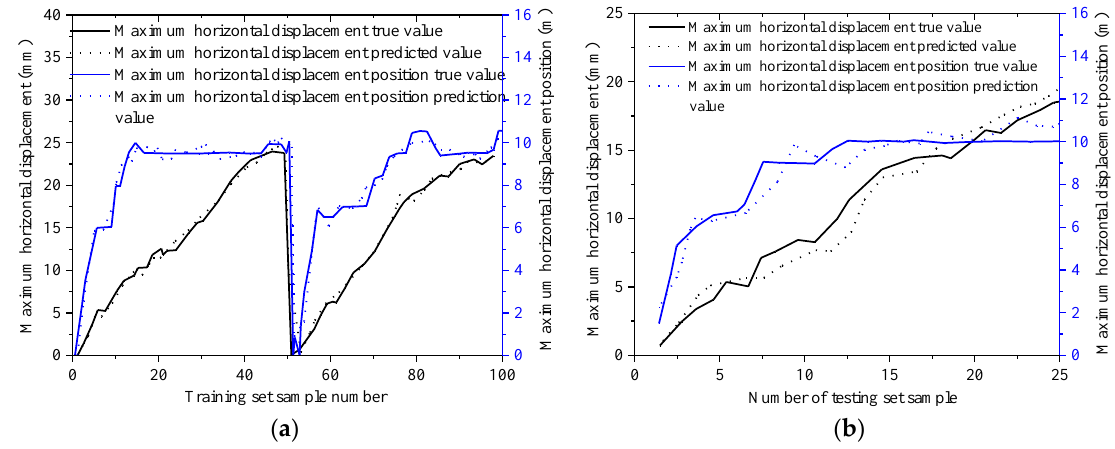
Figure 5. Comparison of the training prediction results: ( a ) training set and ( b ) testing set.